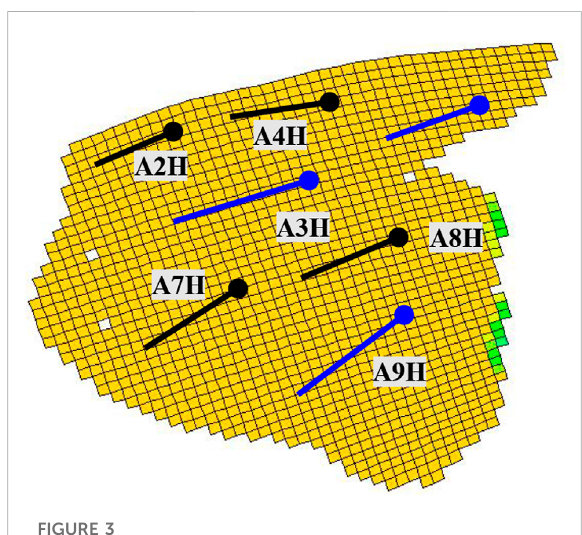
FIGURE 3 Well location map of A sandbody in offshore B oil fi